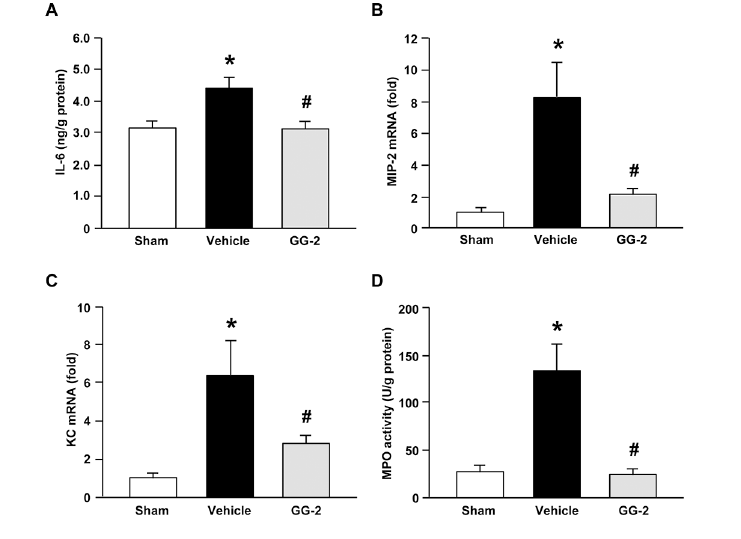
Figure 3. Effect of the combined treatment on lung inflammation in aged septic